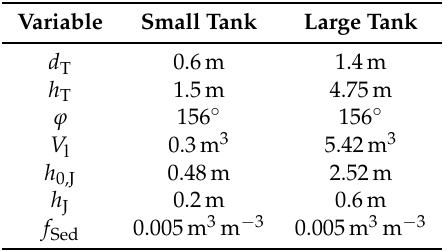
Table 2. Case studies: software input data for the small and large tank geometry.